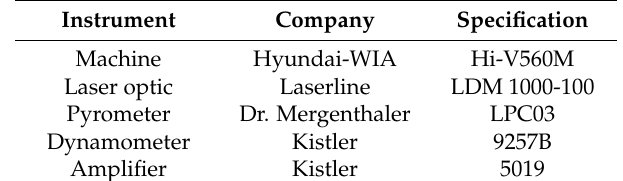
Table 5. Specifications of the experimental set-up.